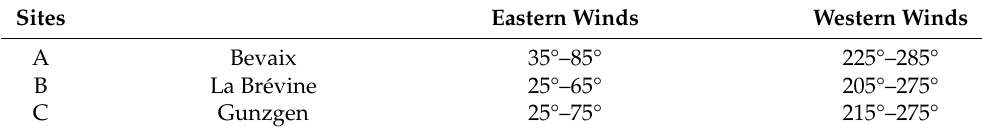
Table 7. Main wind directions for the three study